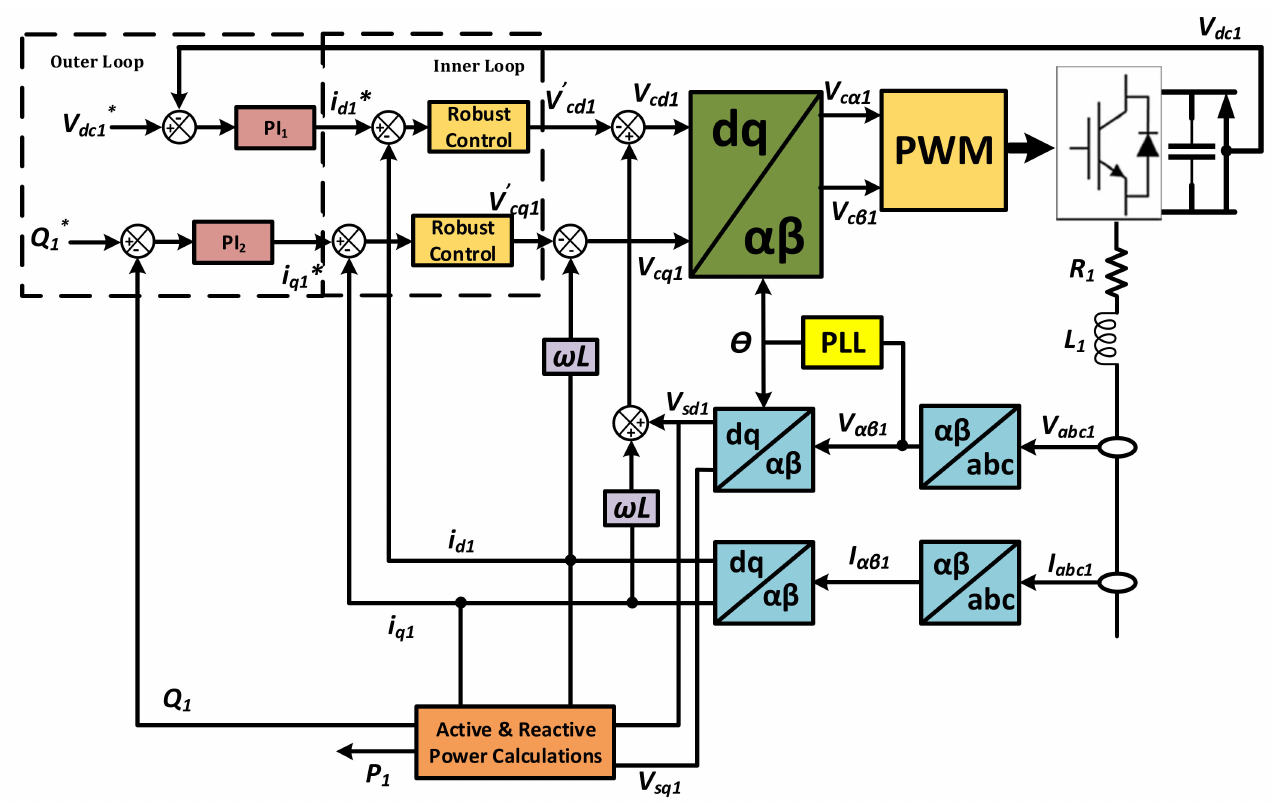
Figure 2. Control scheme at the rectifier station showing the robust controller for the inner d-q current loop, * reference input.